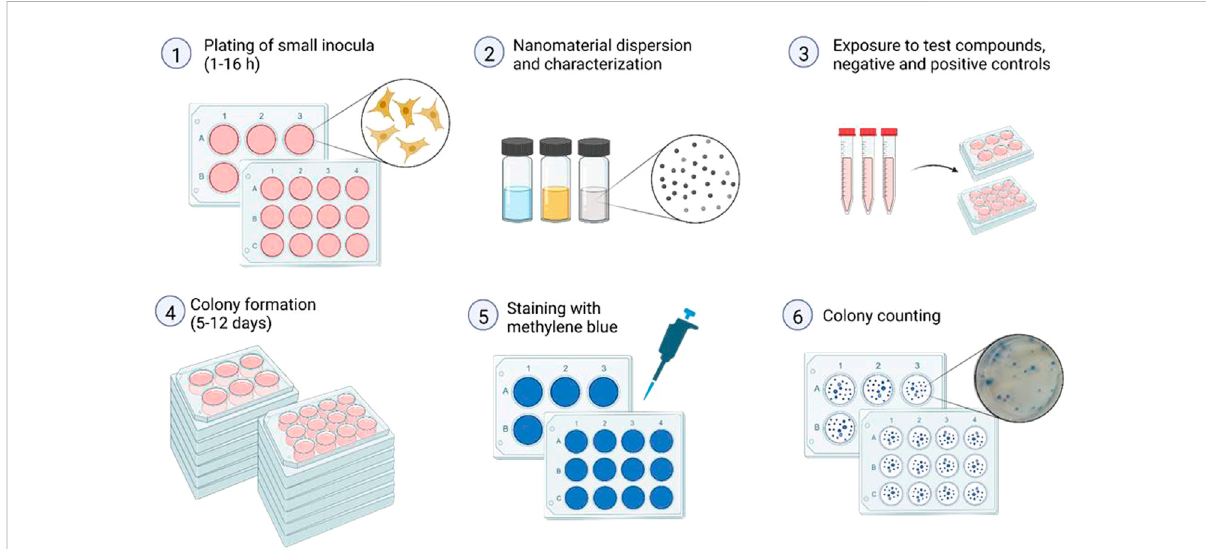
Graphical design of the colony forming ef fi ciency (CFE) assay (Created with BioRender.com). 1. Trypsinize and count the cells. Seed the cells in correct density. It isimportant to mixthe suspension prior to plating to ensure an even suspension of cells, as well as to spreadthe cells evenly inthe wells. Remember to label both lid and the plate properly to avoid mix-up. Keep the cells in the incubator. 2. Prepare dispersion of NMs. Perform proper particle characterization. 3. Dilute NMs and controls in culture medium and add to the plates. Remember to make 2 × concentration since there is already half of medium in the well. 4. Leave the plates with the cells in the incubator to form colonies, normally 5 – 12 days 5. When colonies visible by eye are formed in negative control plates, the colonies should be stained in 1% methylene blue. Add 20 µl of methylene blue into each well and leave for minimum 30 min. Remove the staining solution into waste bottle. To reduce background staining, the plates can be rinsed carefully with water after staining. Leave the plates to dry. 6. Count the colonies. h, hours; d,